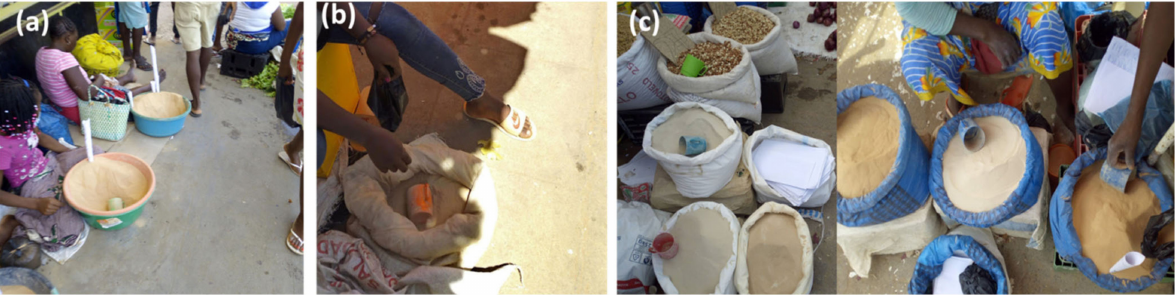
Figure 3. Geophagic material markets in Maputo City: ( a ) Xipamanine; ( b ) Xiquelene; and ( c ) Zimpeto